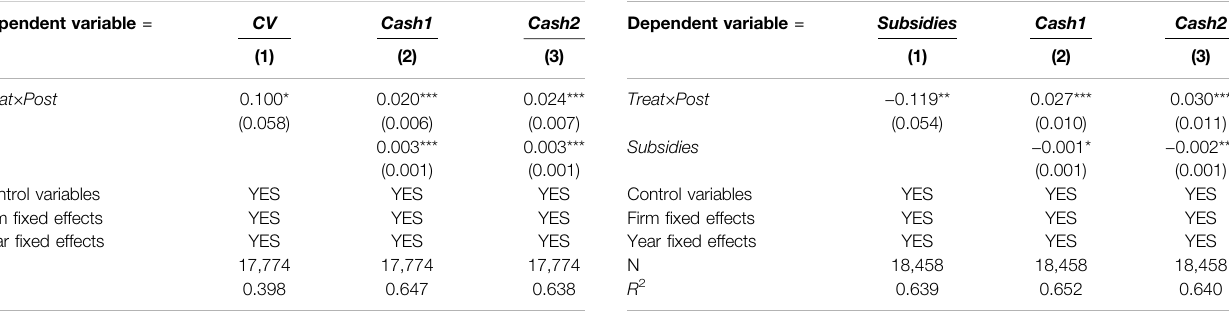
TABLE 9 | Mechanism analysis: